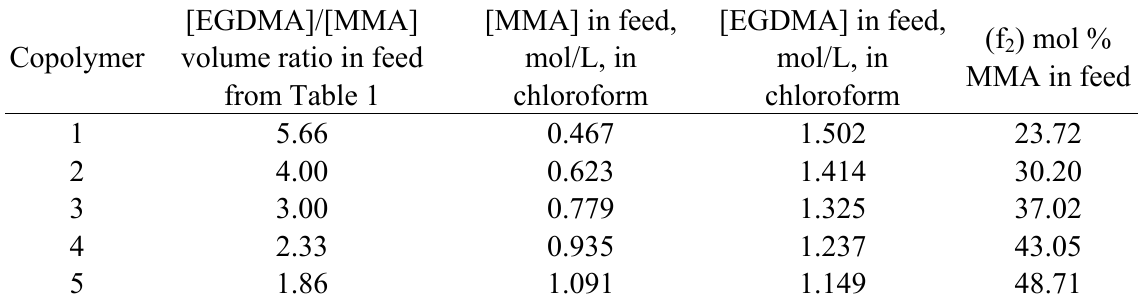
Table 4. EGDMA/MMA Copolymer Analysis by IR Spectroscopy (III). Copolymer No.